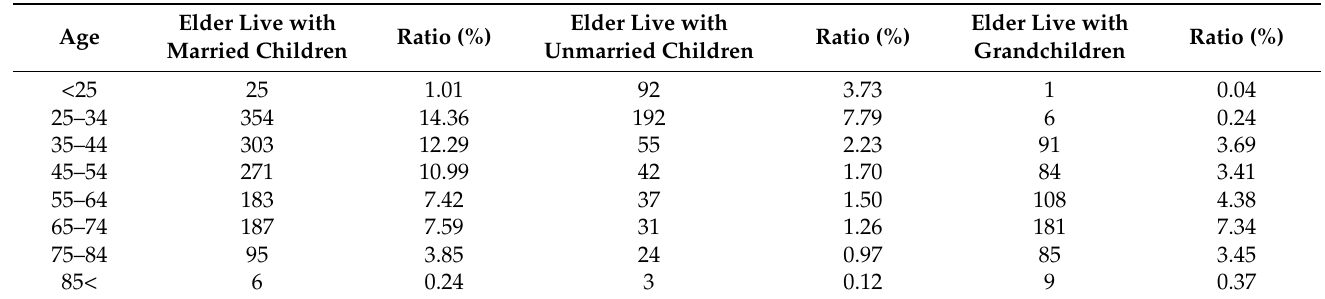
Table 1. Sample distribution.